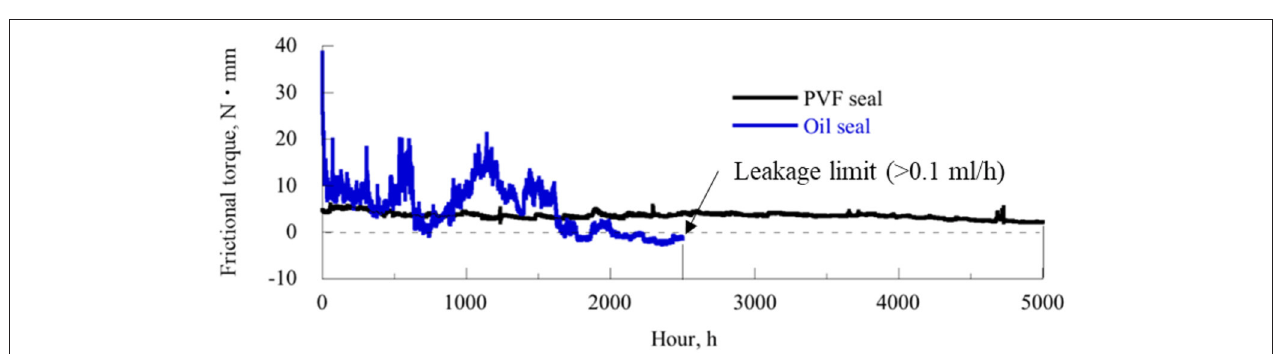
FIGURE 6 | Frictional